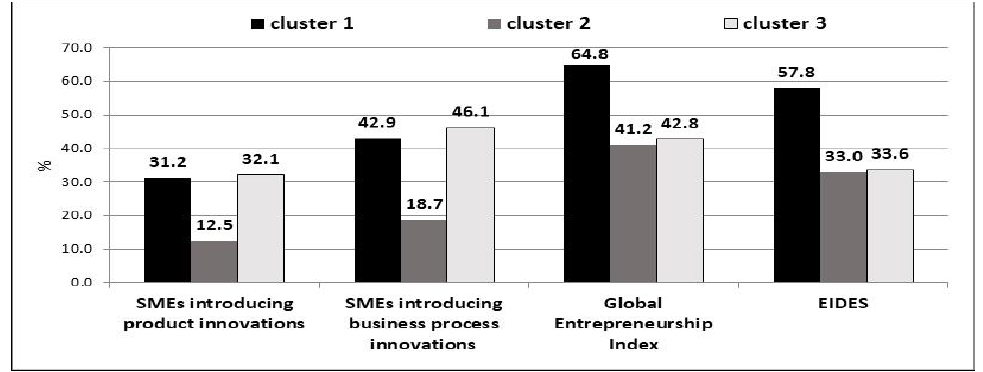
Figure 5. Digital, innovative and productive entrepreneurship (mean values per cluster). Source: own calculations based on [26,87,88].